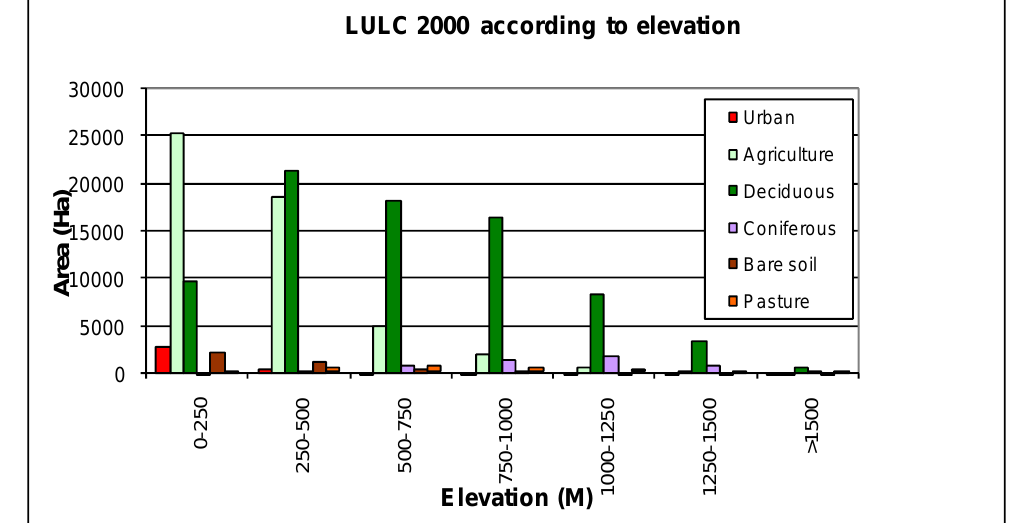
Figure 6 . Land use\land cover values that belong to 2000 according to